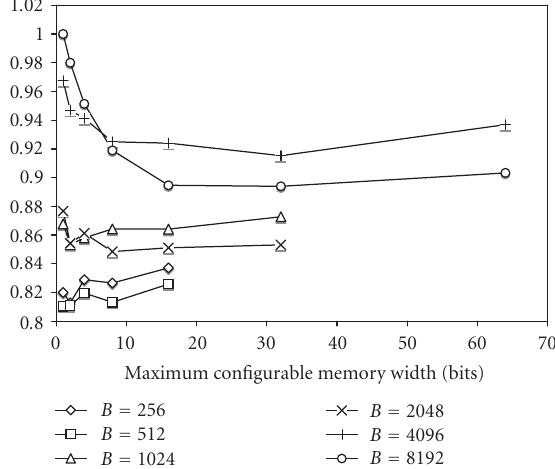
Figure 14: Impact on overall energy when increasing memory flex-